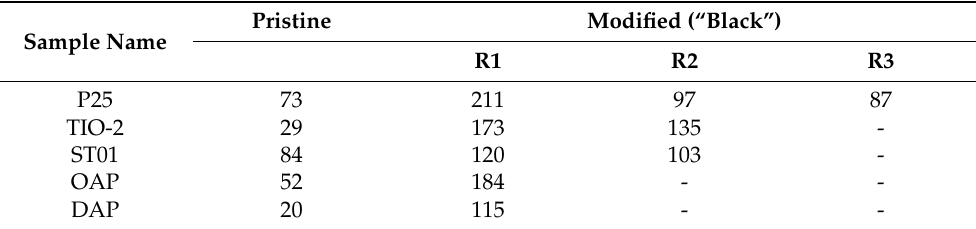
Figure 4. Energy distribution of the ETs present in the ST01, ST01-R1 and ST01-R2 samples. The total density of ETs is written above the sample names. Table 2. Defect density [ µ mol g − 1 ], estimated by photochemical